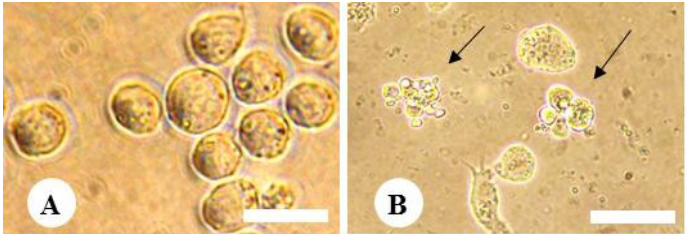
Figure 6. Effect of Natsuhaze ethanol extract on morphological change of HL-60 cells ( A , B ) and nuclei ( C , D ). ( A , C ) Control. ( B , D ) HL-60 cells treated with ethanol extract of Natsuhaze at 0.5 mg ・ mL −1 . Black arrows indicate the typical apoptotic cells, and white arrow indicates the nuclear condensation. Bars indicates 20 µm ( A , B ) and 0.5 µm ( C , D ),